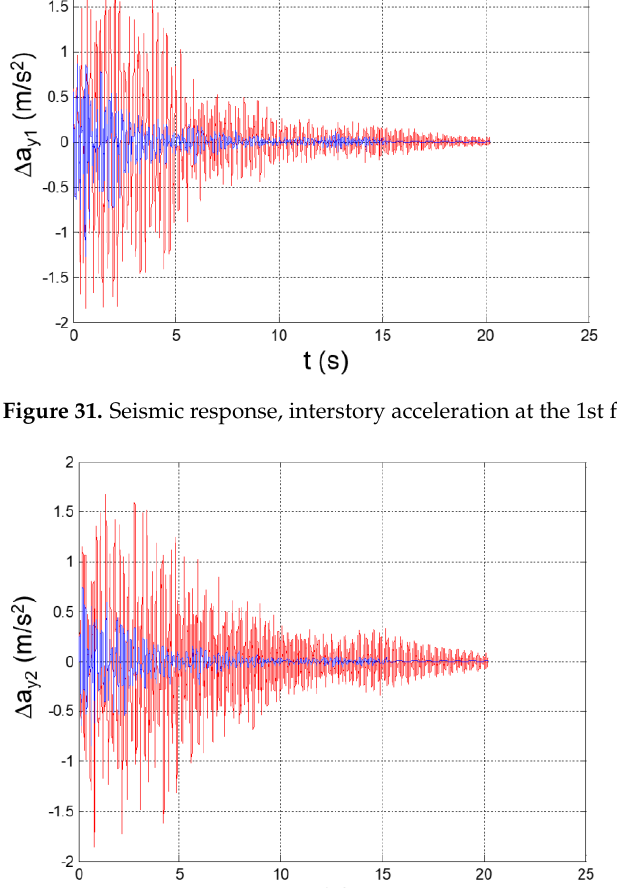
Figure 32. Seismic response, interstory acceleration at the 2nd floor ( Δ 𝑎 y2 = 𝑎 y2 − 𝑎 y1 ).